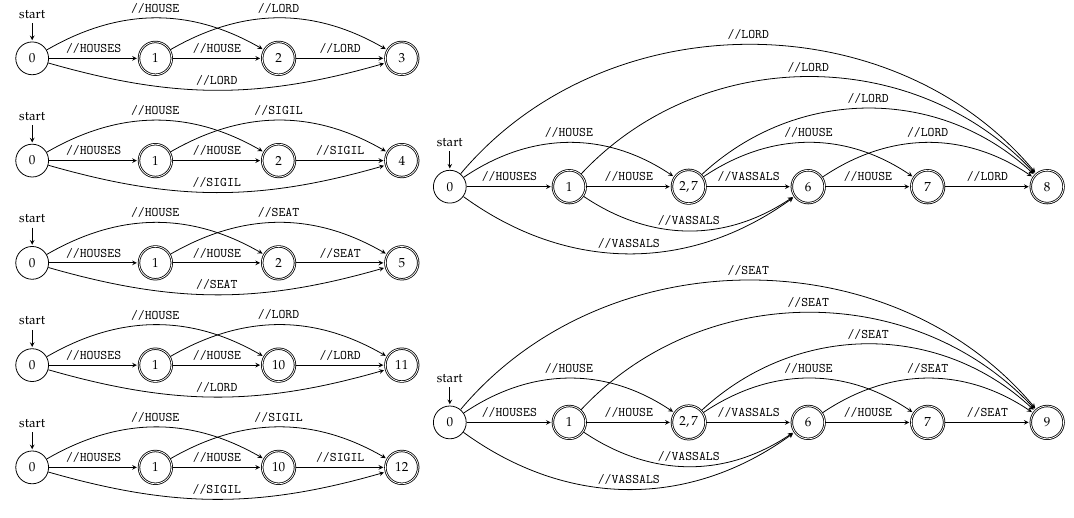
Figure 4. Subsequence automata for individual string paths of the XML tree model T from Figure